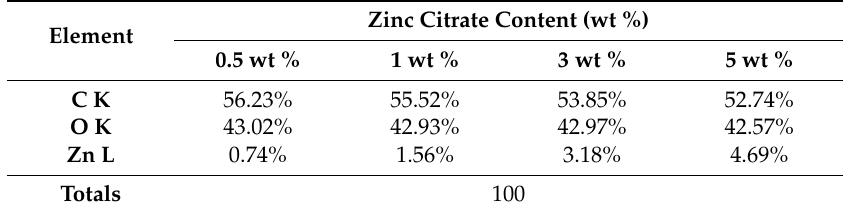
Figure 7A. The pure PVA nanofiber mats are not bacteriostatic. In contrast, the addition of different